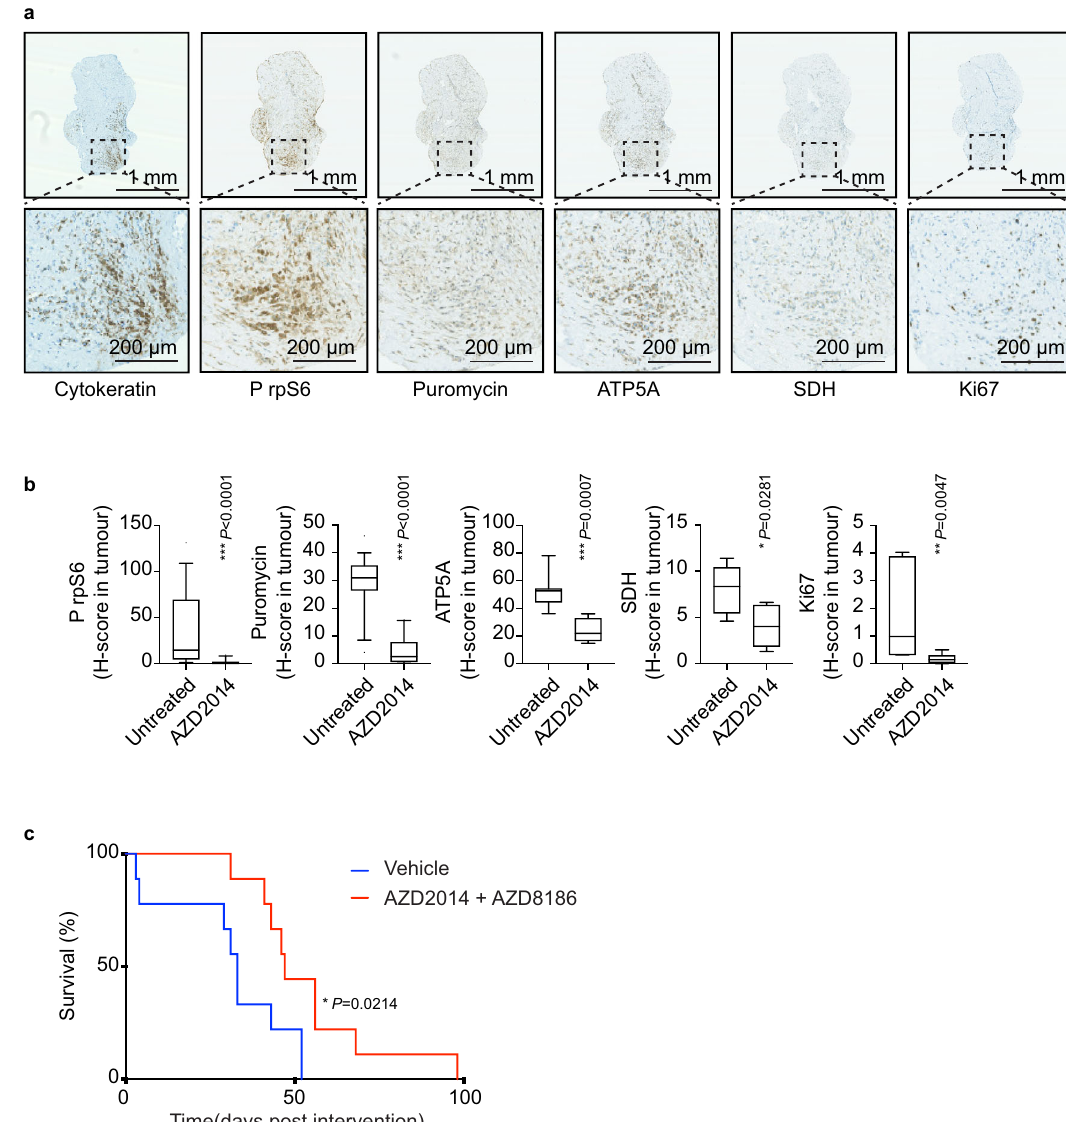
Fig. 7 mTORC1 and 2 inactivation inhibits tumour cell growth ex vivo and in mouse models of MpM. a Representative sections of mesothelioma explants stained with the indicated antibody. Cytokeratin staining was used to identify tumour areas within the explants. Scale bar 1 μ m, 200 μ m for the call outs. b Mesothelioma explants were cultured for 72 h with 100 nM AZD2014 or with vehicle. H-score quanti fi cation of IHC staining within tumour areas is performed by Visiopharm ® software. Mann – Witney signi fi cance test was performed (two patients, n = 8 explants, each p values are shown on the graph). The box plots show the box from the fi rst quartile to the third quartile. The middle line represents the median. The whiskers go up to the maximum and minimum values. c Adult mice ( Cdkn2a − / − ;Nf2 fl / fl ;Tp53 fl / fl ) were intrapleurally injected with 107 pfu Lenti-Cre, followed after 10 days by a single intrapleural injection of 25 μ g of long fi bre amosite asbestos and allowed to age for a further 50 days. The mice were treated with AZD2014 + AZD8186 ( n = 9 mice) or vehicle control ( n = 9 mice), from d60 post-viral induction of fl oxed alleles. Graph shows survival from the fi rst day of treatment (Mantel – Cox log-rank